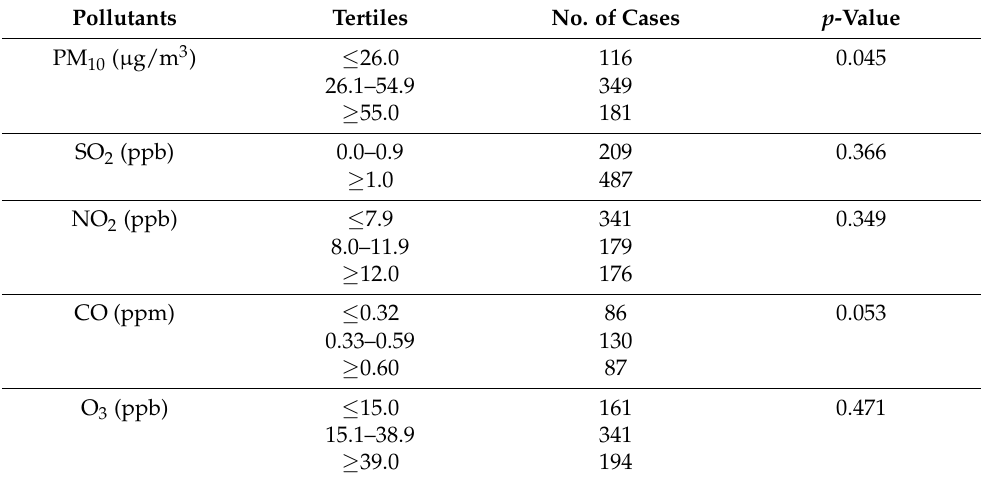
Table 7. Tertiles of exposure to air pollutants of study population during months of enrollment.